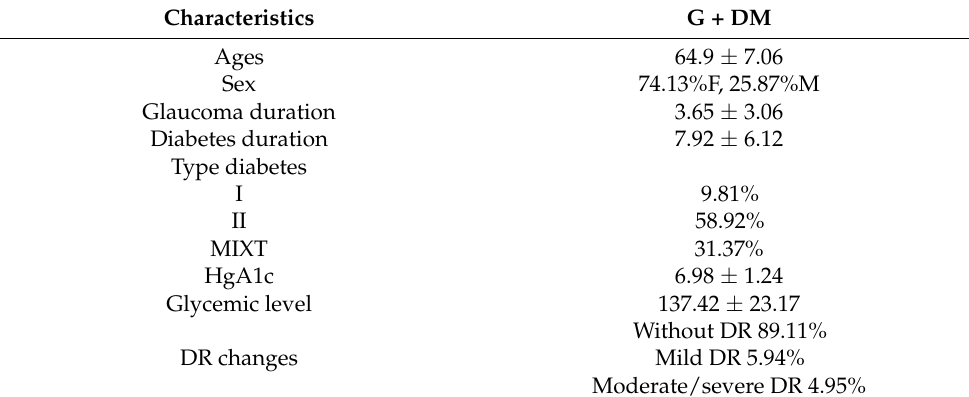
Table 1. Characteristics of the patients included in the